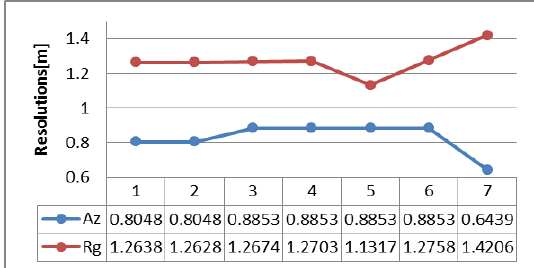
Figure 17. KOMPSAT-5 SAR image of the deployed CRs Spatial resolution is defined as the distance in meters between the points to either side of the peak in a one-dimensional cross- section through the impulse response function which are 3dB below the interpolated peak power. The range (Rg) and azimuth (Az) resolution assessed with CRs is shown in Figure 18. Note that the ground range instrument geometric resolution is 1.21m and azimuth instrument geometric resolution is 0.90m.